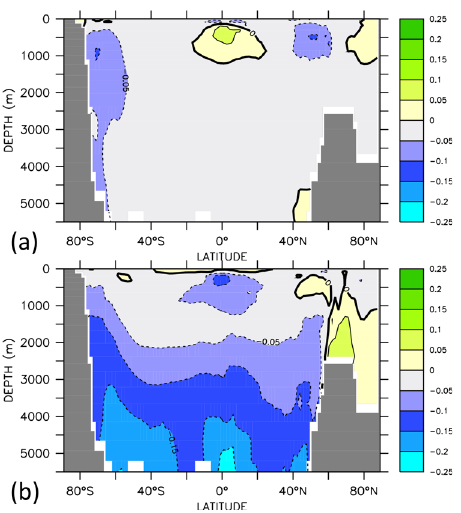
Fig. 5 Zonally averaged relative changes in the metabolic index. a Changes in metabolic index Φ (see “ Methods ” ) for year 2020 with